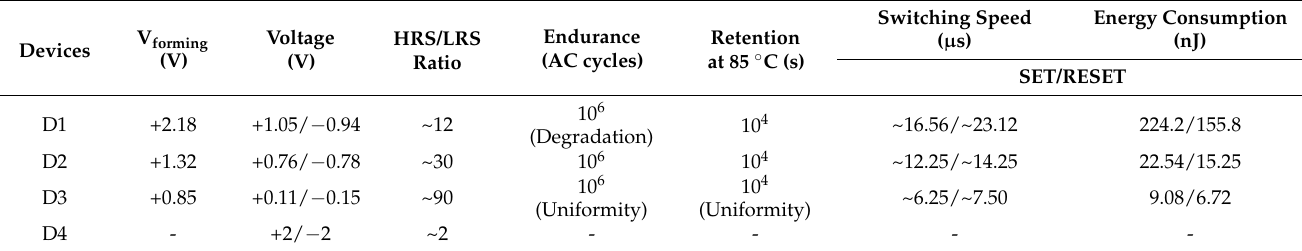
Figure 6. Switching speed of SET/RESET pulse pair for ( a ) D1, ( b ) D2, and ( c ) D3 devices. The black lines are the applied voltage pulses and the blue lines, green lines, and red lines are the separate current response pulses. Table 1. Summarized the RS performance of undoped and S-doped HfOx-based devices.